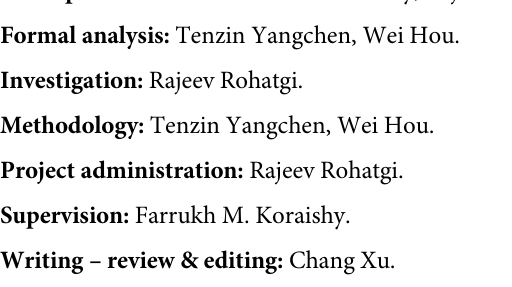
S3 Table. Tertiles of MABP in COVID-19 (-) patients. S4 Table. Comparison of hypertensive COVID-19 positive patients who died and survived. S5 Table. Comparison of non-hypertensive COVID-19 positive patients who died and